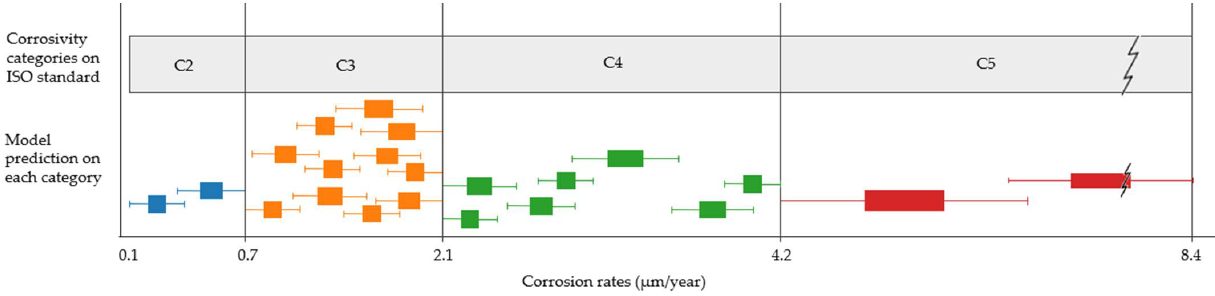
Figure 13. Comparison between each category range offered by the standard using the informative procedure and the possible mean values and uncertainties offered by the model, represented by clustered boxplots on each category.